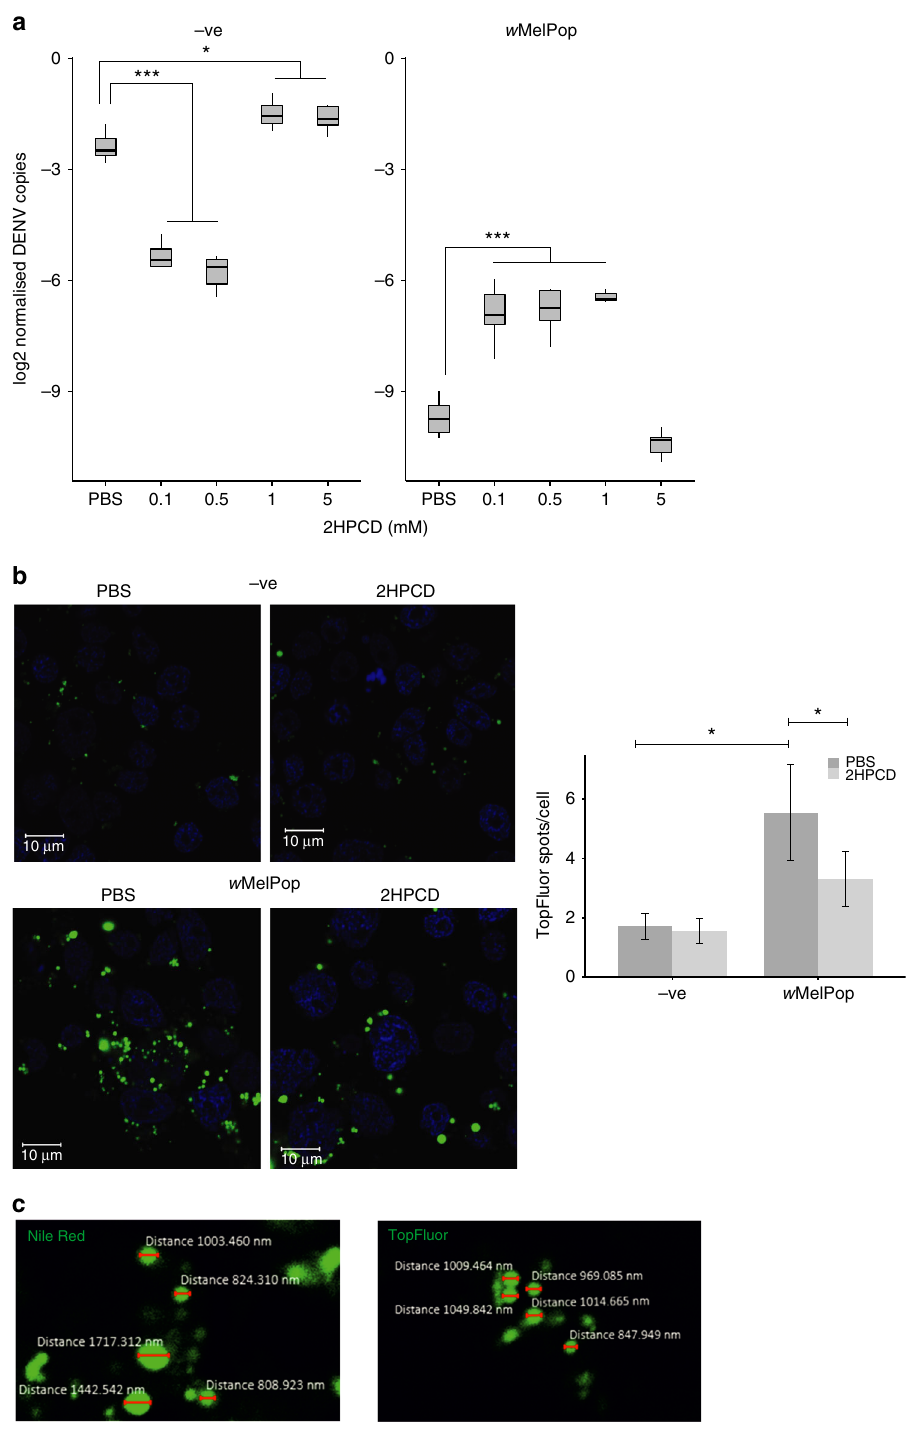
Fig. 2 Pretreatment of Wolbachia- infected Aag2 cells with low concentrations of 2-hydroxypropyl- β -cyclodextrin (2HPCD) reverses inhibition of DENV replication. a Uninfected cells ( – ve) and w MelPop-infected cells were treated for 48 h with various concentrations of 2HPCD prior to addition of DENV virus at a multiplicity of infection of 0.1. Cells were harvested 5 days post infection and DENV levels measured by qPCR. Signi fi cant differences of < 0.05 are indicated as determined by analysis of variance (ANOVA) corrected by Tukey ’ s HSD test, n = 5. b Cholesterol turnover imaged using TopFluor cholesterol. Uninfected and w MelPop-infected cells were pretreated with either PBS or 0.1 mM 2HPCD for 24 h. Cells were then labelled with TopFluor cholesterol for 30 min and subsequently incubated with either PBS or 0.1 mM 2HPCD for 24 h before imaging by fl uorescence confocal microscopy; scale bar indicates 10 µ m. Lipid droplets were quanti fi ed as TopFluor-positive spots/cell; error bars denote s.d. Statistical signi fi cance was assessed by ANOVA corrected by Tukey ’ s HSD test, n = 5. c Imaging of Nile Red stained or TopFluor-treated w MelPop cells and measurement of lipid droplet